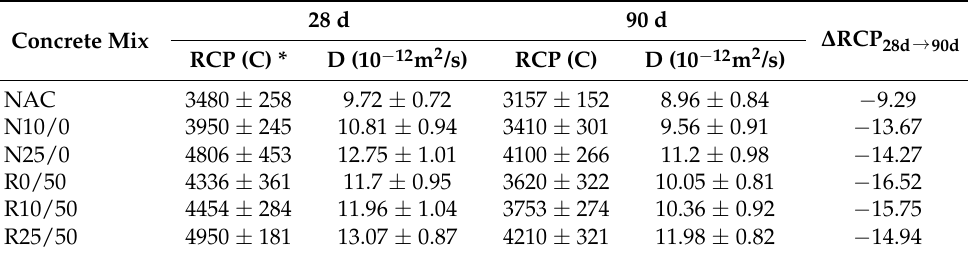
Table 5. Rapid chloride penetration (RCP) and chloride diffusion in 28 d and 90 d mixes ( ± , standard deviation).